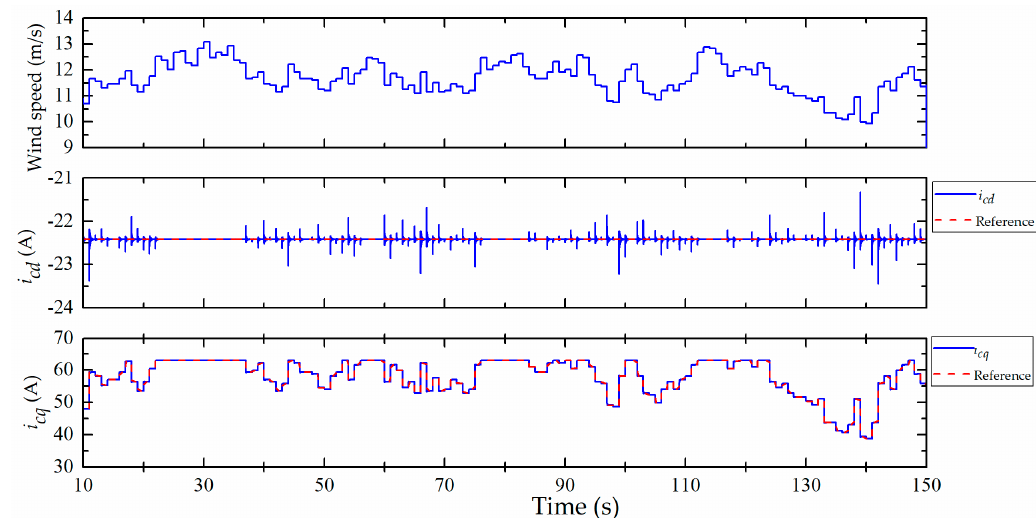
Figure 15. Dynamic responses of the CW currents in Case II.